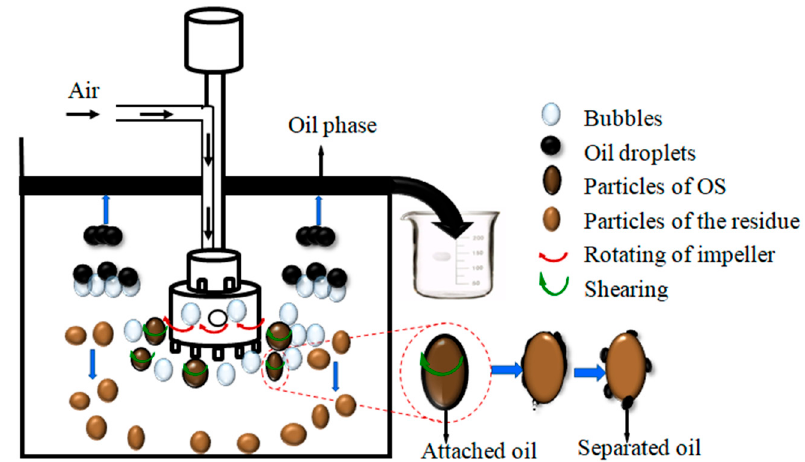
Figure 9. Mechanism of oil separation from solid particles by froth flotation.